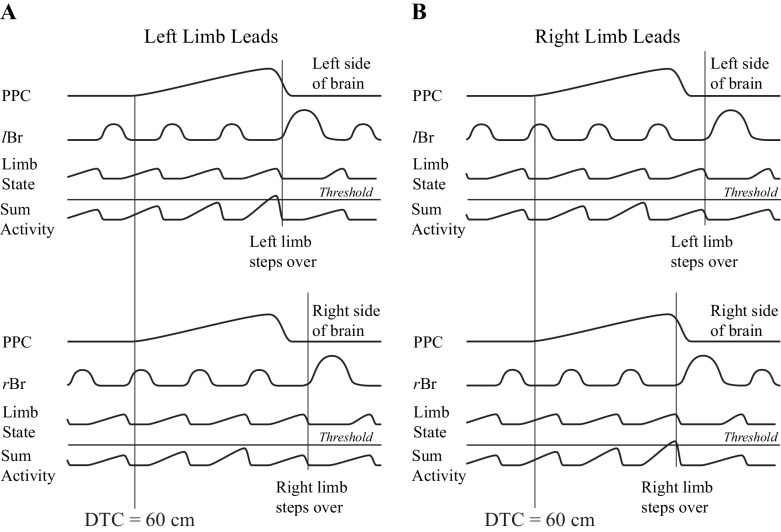
Conceptual model illustrating a possible mechanism for limb selection.Left (A) and right (B) limb lead conditions. The top parts of A,B show activity on the left side of the brain and the bottom parts of A,B, show activity on the right side of the brain. In each part of the figure, the traces represent, from top to bottom, the population neuronal activity in the PPC, EMG activity from the left or right Br, a signal representing limb state, and the integrated (summed) activity of these two traces. We suggest that the signal from the PPC, providing information on gap closure, is integrated with a second signal providing information on limb state, on each side of the brain. Whichever integrated signal crosses a threshold level first determines which limb will be selected to be the first to negotiate the obstacle. The population neuronal activity in this illustration is assumed to start 60 cm before the step over the obstacle in both the left and right limb leads conditions. Whether the animal steps over with the left or right limb depends on when cell activity begins with respect to the ongoing locomotor activity of the animal. In A, a threshold level is achieved first on the left side (top illustration), whereas in B, the threshold level is achieved first on the right side (bottom illustration). Note that the integrated value will only cross the threshold level when the signal from the moving limb shows it to be in a state that is appropriate to negotiate the obstacle (e.g. the end of stance).